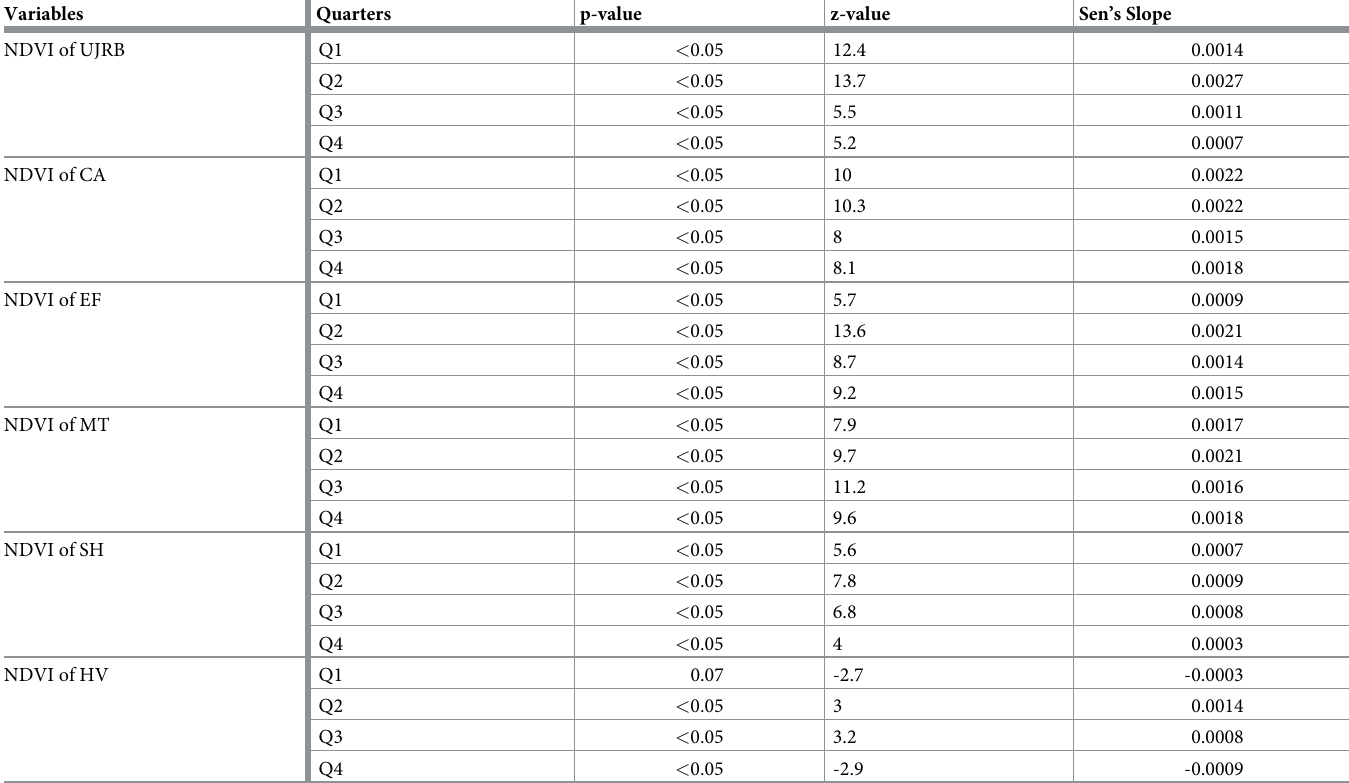
Table 2. Seasonal Mann-Kendall trend statistics calculated from spatially averaged data over the whole UJRB and each vegetation class in four quarters (Q1, Q2, Q3 and Q4) during 1982 to 2013.